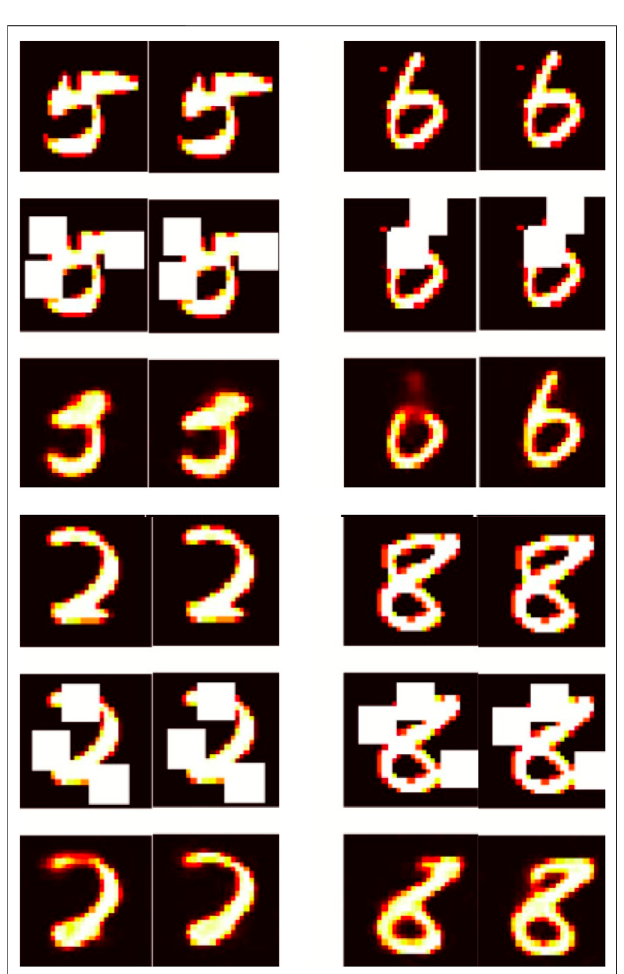
FIGURE4| IllustrationofreconstructionresultsforMNISTexamples:For eachpanel,the fi rstcolumnreferstozero-ConvAEresultsandthesecondone to FP(15)-ConvAE. The fi rst row depicts the reference image, the second row themissing datamask, and the third one the interpolated image. The fi rst two panels illustrate interpolation results for training data and the last two for test data. We depict grayscale amid images using false colors to highlight